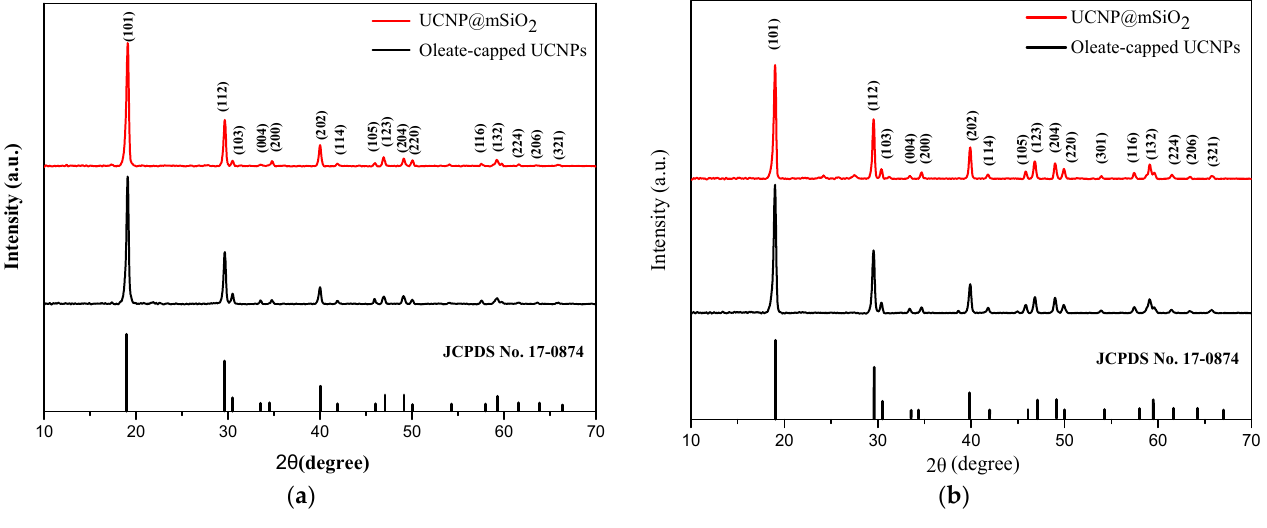
Figure 1. Wide-angle X-ray diffractograms of the oleate-capped and mSiO 2 -coated core/shell nanoparticles. ( a ) LiYF 4 :Yb 3+ 0.25 ,Ho 3+ 0.01 @LiYF 4 :Yb 3+ 0.2 , ( b ) LiYF 4 :Yb 3+ 0.25 ,Er 3+ 0.01 @LiYF 4 :Yb 3+ 0.2